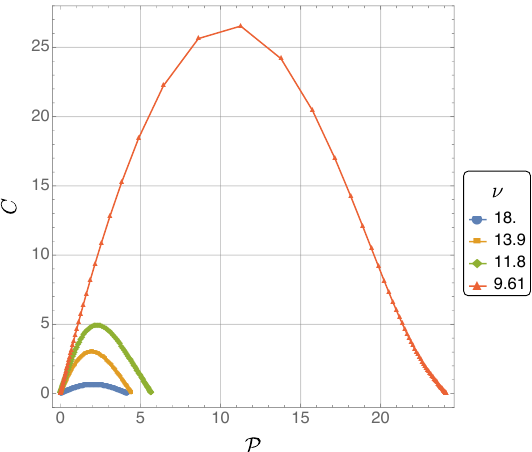
Figure 24 . The circumference C of the (cid:30) circles as a function of proper distance P for (cid:12)xed (cid:22) = 18 and using y + as in eq. (4.49) for the new solutions: di(cid:11)erent symbols correspond to di(cid:11)erence choices of (cid:23) . For (cid:22) = 18, the D2/D1 interface is located around (cid:23) (cid:25) 9 :